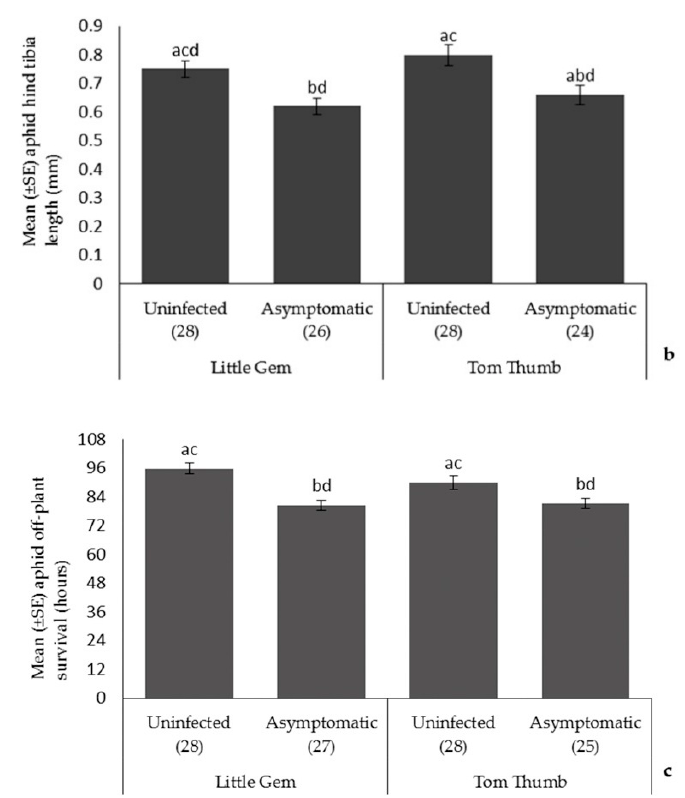
Figure 1. The effect of asymptomatic B. cinerea infection status and plant variety on Mean ± SE ( a ) cumulative number of aphid offspring; ( b ) aphid hind tibia length; and ( c ) aphid off-plant survival. Number of replicates per treatment is shown below each bar; treatments sharing the same letters above each bar are not significantly different at p < 0.05 following post-hoc tests.